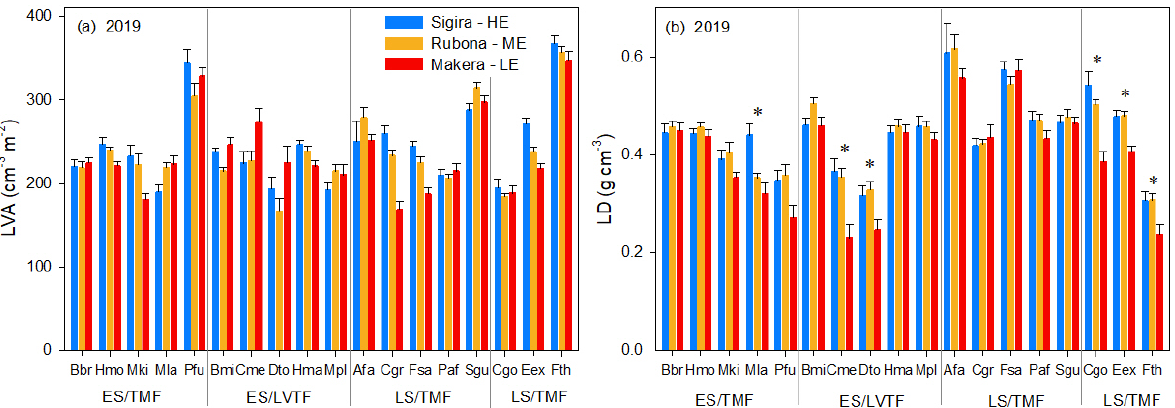
Figure 5. ( a , b ) Site (i.e., warming) effects on ( a ) leaf volume per area unit (LVA) and ( b ) leaf density (LD) in 18 species (see Table 1 for full names) measured at three sites of different elevation (HE, ME and LE, high, mid and low elevations, respectively) in 2019. The species are divided into four groups, depending on successional stage and forest type of origin. ES and LS, early and late successional, TMF, tropical montane forest and LVTF, Lake Victoria transitional forest. * indicates statistical differences between sites within species ( p < 0.05); see Table 4 for detailed statistical results. Note that there was no significant species x site interaction for LVA, and therefore the site effect for individual species was not analysed.